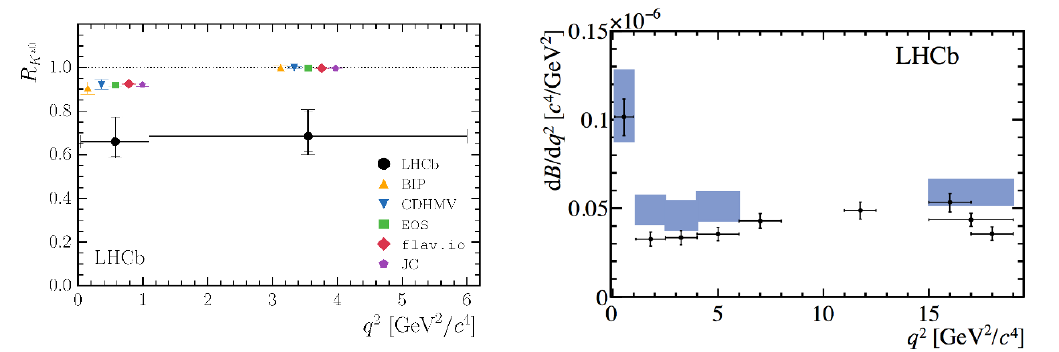
Figure 1. R K (cid:3) (left panel) and extracted from refs. [23] and [24]